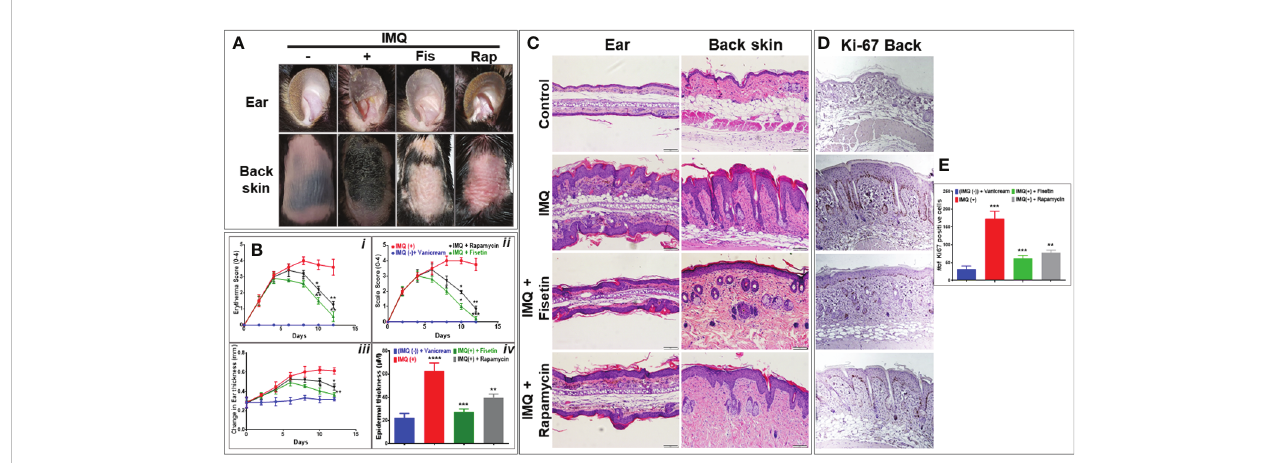
FIGURE 5 Fisetin improves clinical scores, alleviates epidermal hyperplasia, and reduces Ki67 in epidermis of IMQ-induced skin lesion in C57BLC6 mice. (A) Representative preclinical photographs of ears, and back skin of IMQ-treated C57BLC6 mice treated topically once daily for 10 days with fi setin (50 mg/ kg body weight) or rapamycin (25 mg/kg body weight) compared with vehicle (vanicream) control mice. Psoriasis Area and Severity Index (PASI) was used for scoring. Scale bar = 100 µm. Schematic overview of Timeline of IMQ studies. ( B : i-iii ) Four blinded evaluators scored ears, and skin for erythema, scaling, and ear swelling (thickness). Scoring ranged from 0 to 4, increments of 1, with 0 indicating normal phenotype and 4 indicating a severe psoriasis- like phenotype. (C) Histological H&E-stained ear and skin sections from mice treated with vanicream control (i.e., no Aldara reference), IMQ, fi setin+IMQ, or rapamycin+IMQ. (B; iv ) Microscopic quanti fi cation of average interfollicular epidermal thickness of vanicream control, IMQ, fi setin_IMQ, or rapamycin +IMQ treated mouse skin sections. (D) Immunohistochemical staining of skin sections for Ki67. (E) Quanti fi ed numbers of Ki67-positive cells in basal and suprabasal epidermis from mice with different treatments. Scale bar = 100 µm. The epidermal thickness scoring and Ki67-positive cell average count was calculated from each group (n=6). Four areas per section of a sample were sampled and analyzed. Means ± SE are shown, and paired t test was used to compare values between different treatments. *P <0.05 , **P <0.01 and ***P <0.001 . (-) indicates control